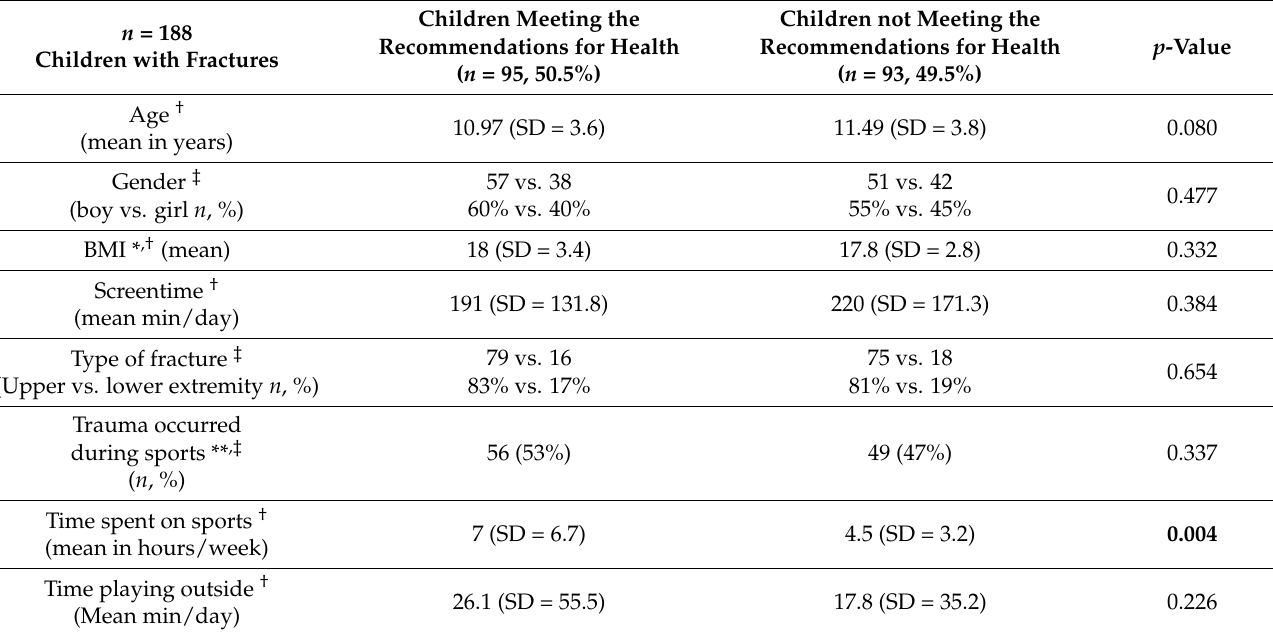
Table 2. Comparing sufficiently physically active children vs. not-sufficiently active